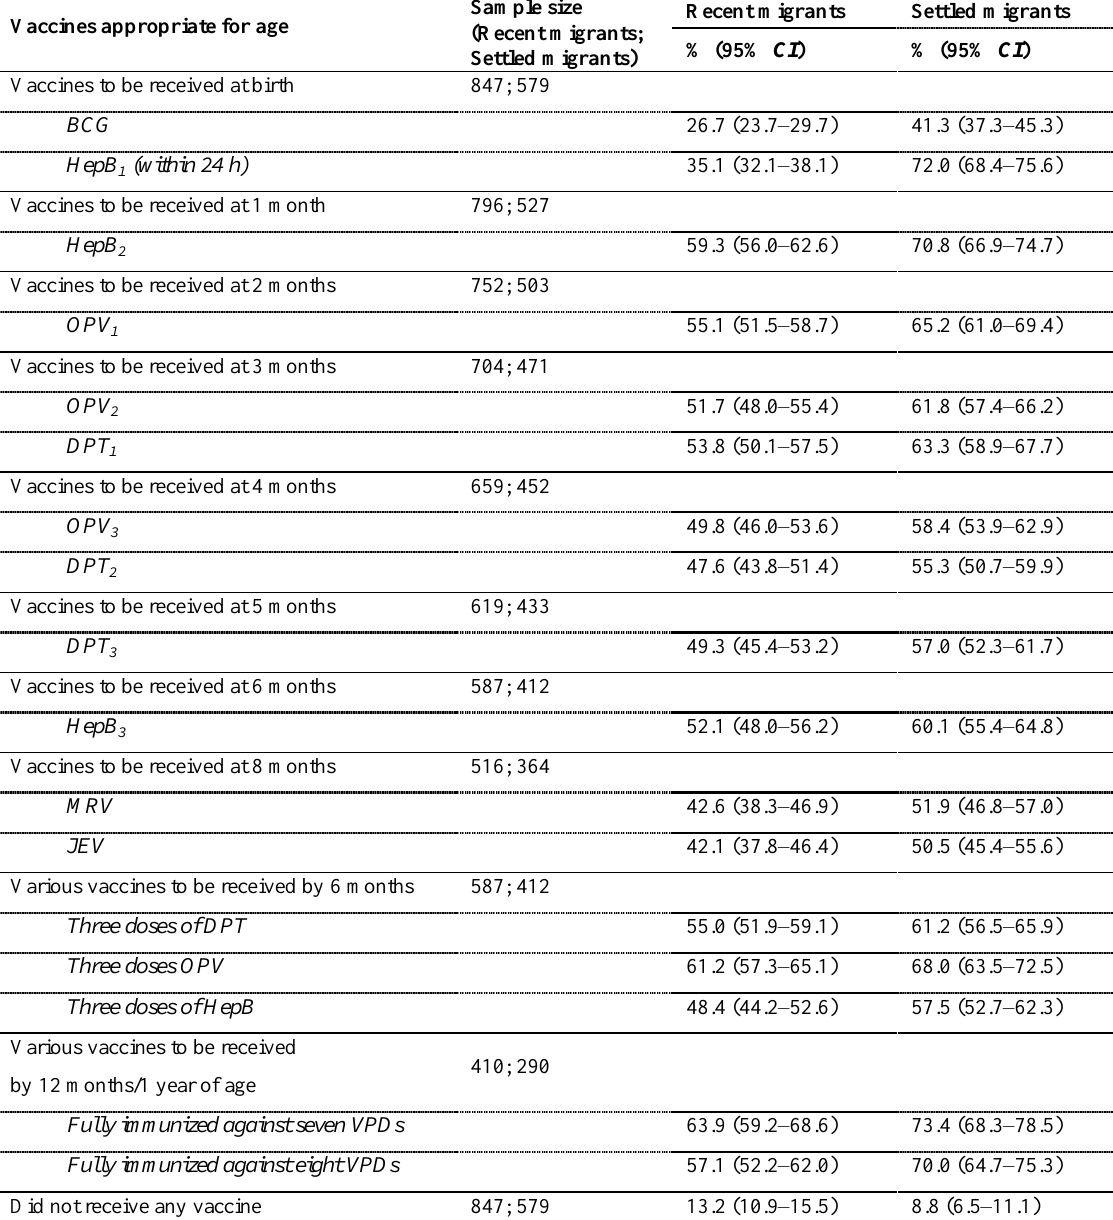
Table 2. Reception of various vaccines appropriate for age among the children of recent and settled